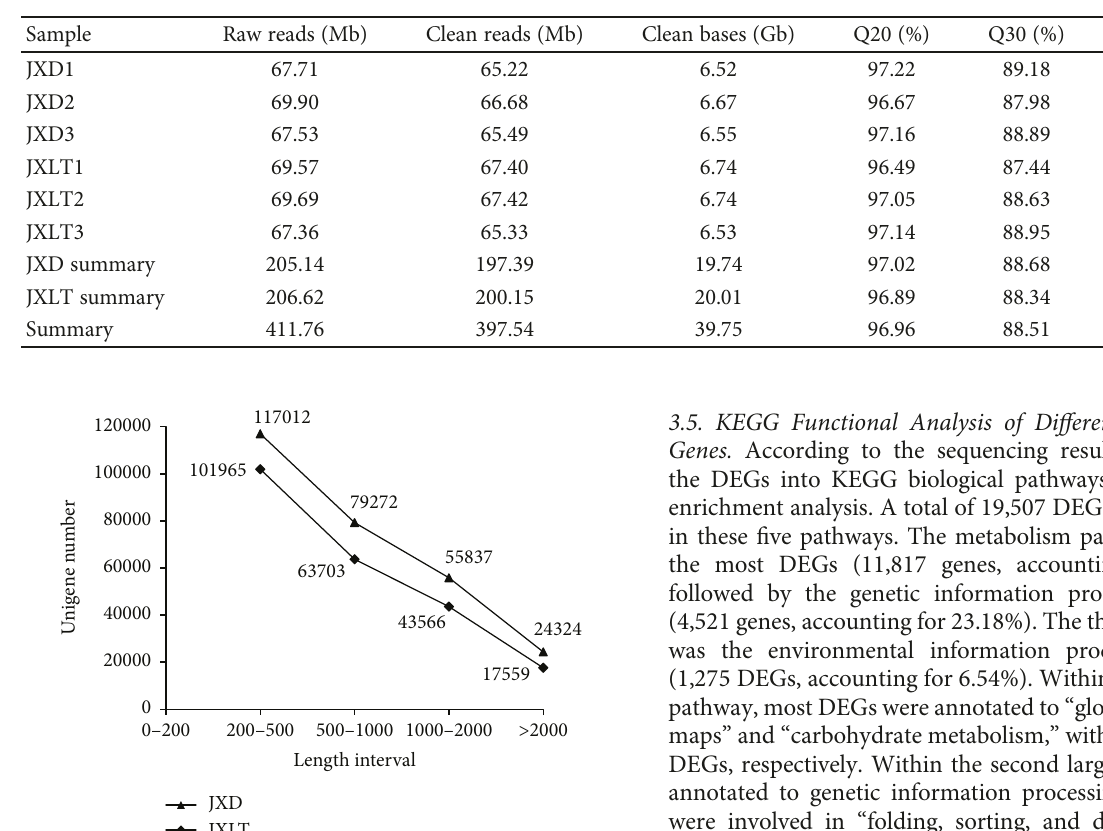
Table 1: Summary of sequence analysis.